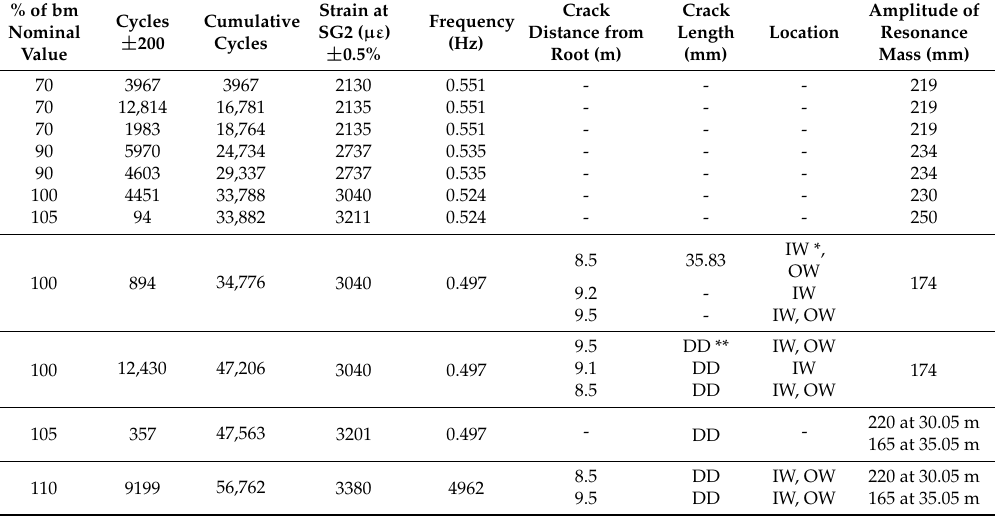
Table 5. Fatigue test results for blade with extended crack to 1000 mm.